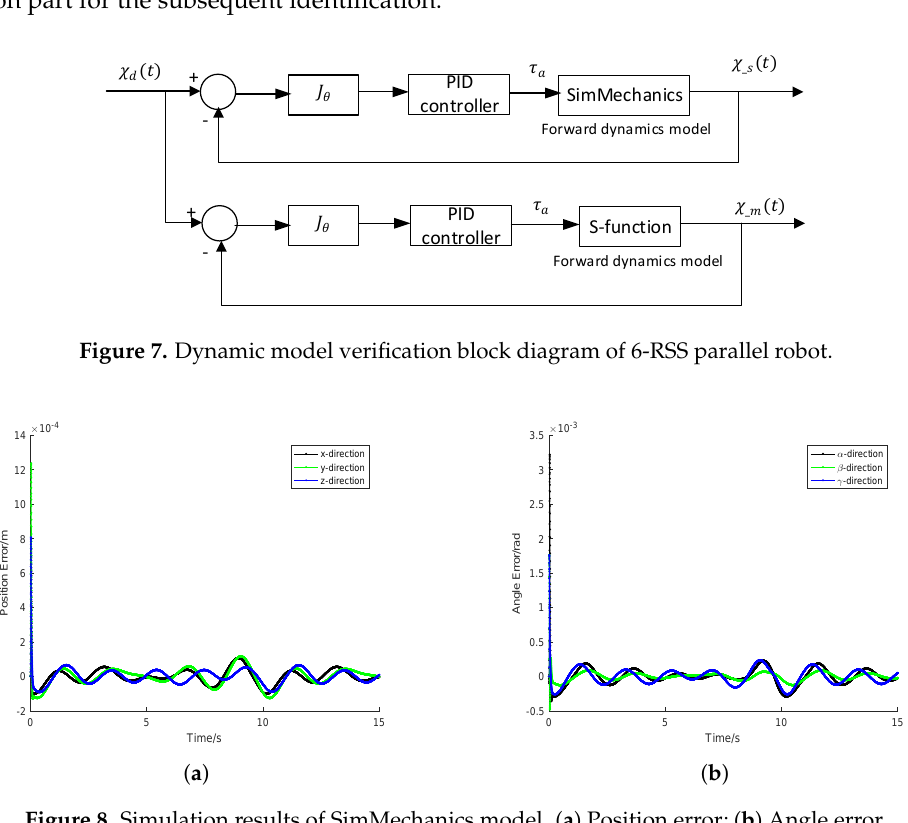
Figure 8. Simulation results of SimMechanics model. ( a ) Position error; ( b ) Angle